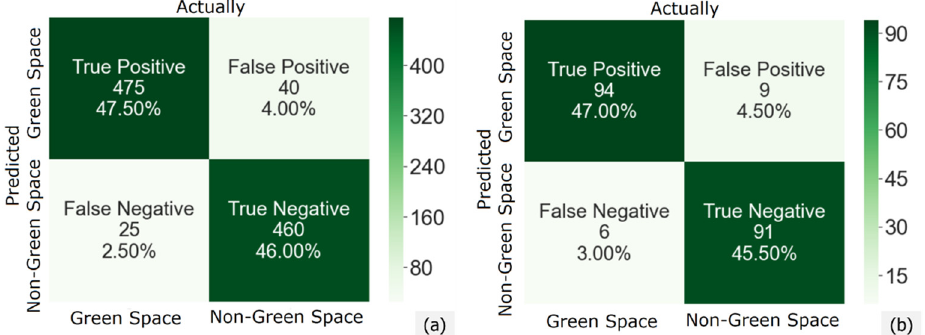
Figure 6. Confusion matrices of the ZFNet DL initial classification results on seen ( a ) and unseen ( b )